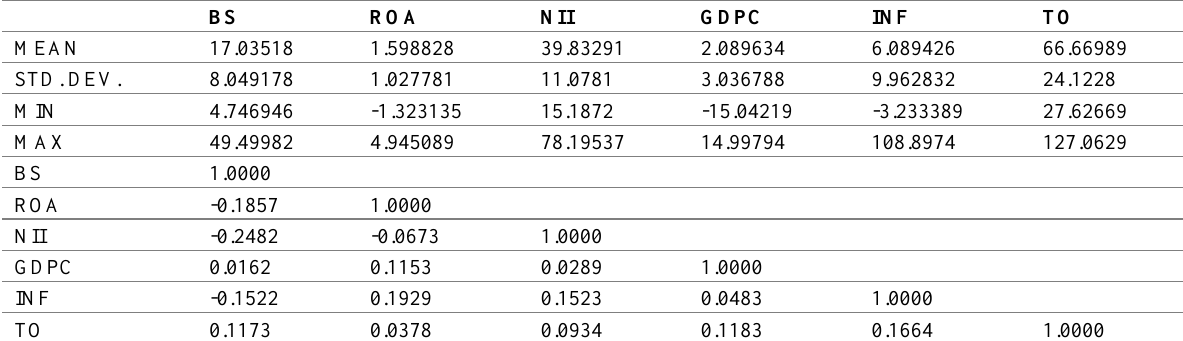
Table 5: Descriptive & Correlation Results